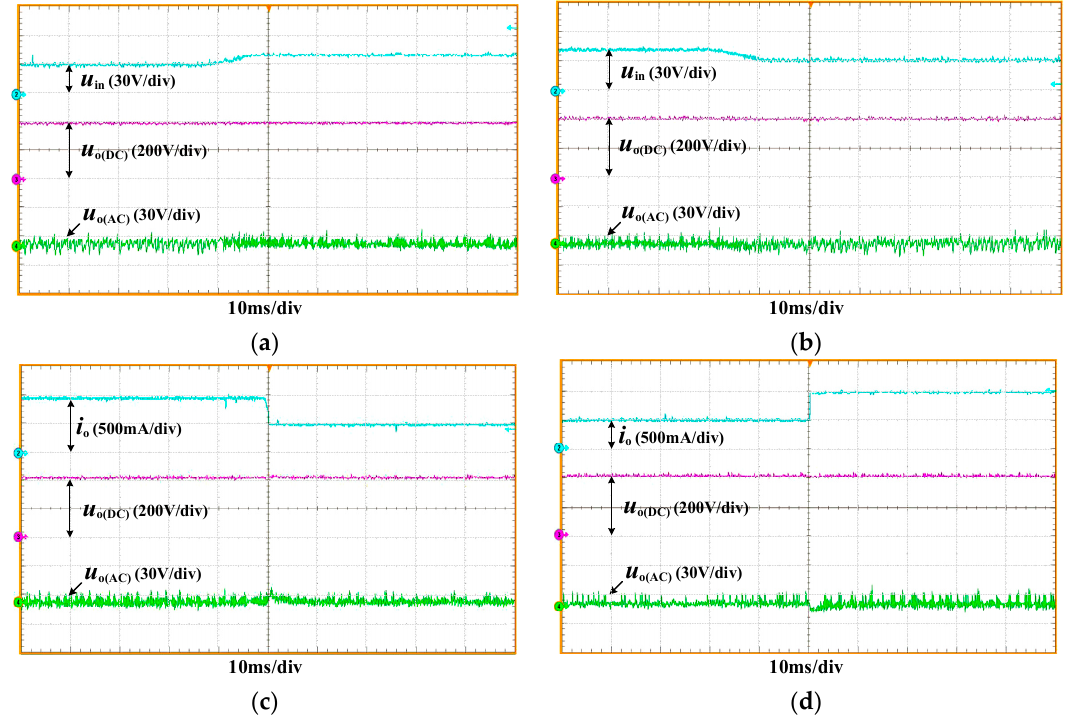
Figure 16. Experimental waveforms of ( a ) input voltage increases from 30 V to 40 V with ramp rate of 1 V/ms; ( b ) input voltage decreases from 40 V to 30 V with ramp rate of ‒ 1 V/ms; ( c ) load resistance increases from 400 Ω to 800 Ω ; ( d ) load resistance reduces from 800 Ω to 400 Ω .